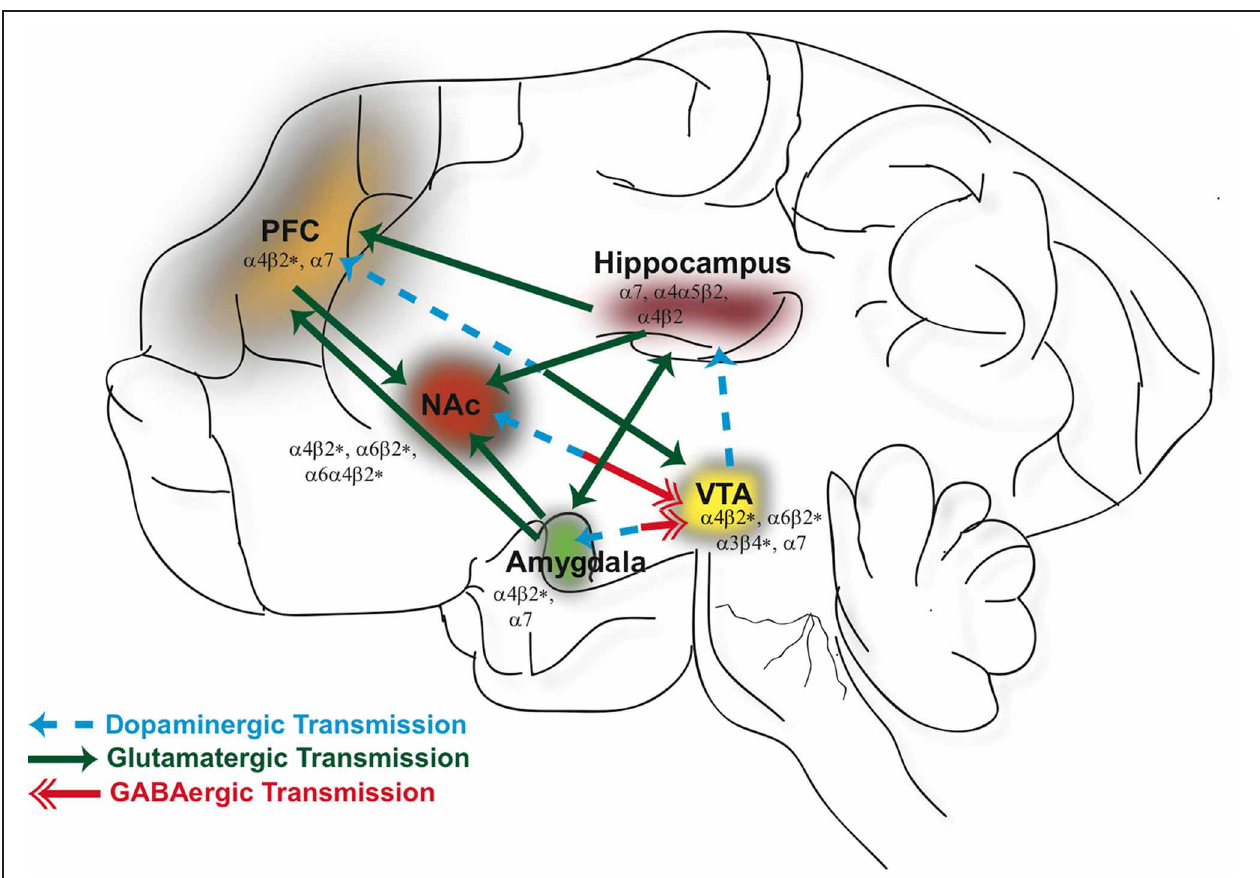
brain areas significantly contribute to the rewarding effects of ethanol and nicotine and play a role in modulating synaptic plasticity. GABAergic (red), glutamatergic (green), and dopaminergic (blue) connections between these structures constitute a major neural circuitry underlying addictive